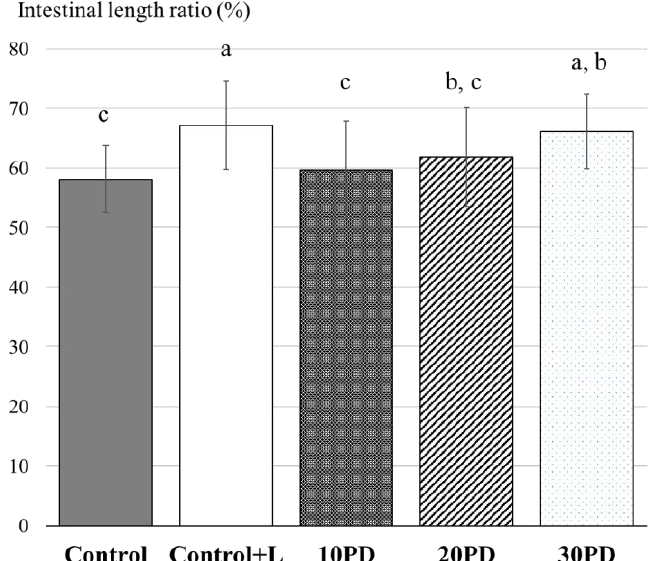
Figure 2. Intestinal length ratio of yellowtail in feeding trial 1. Bars indicated S.D. Different letters indicate statistically significant differences according to Kruskal–Wallis test and Mann–Whitney test with Holm’s correction for post hoc comparison ( p < 0.05).